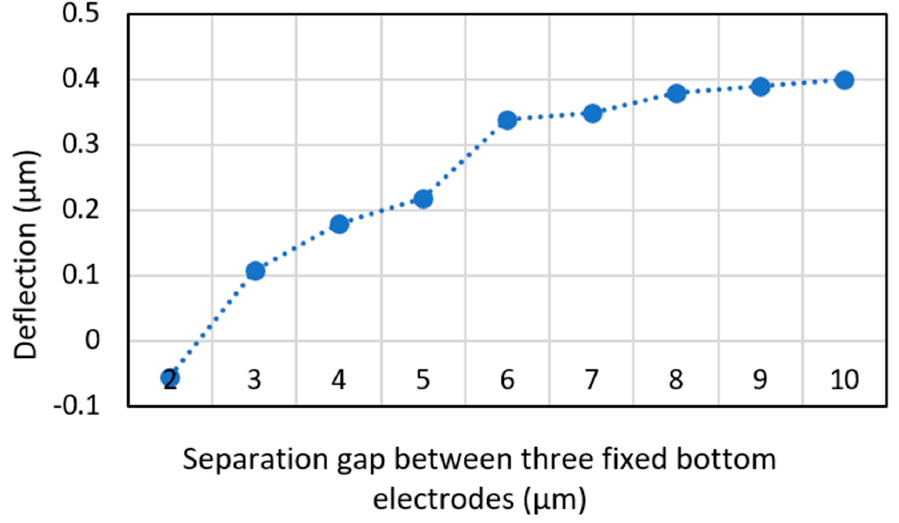
Figure 4. COMSOL simulation results illustrating deflection versus separation distance between fixed bottom electrodes for a micromirror with an L-shaped arm. The length and width of the L-shaped arm are 400 µm and 8 µm, respectively.